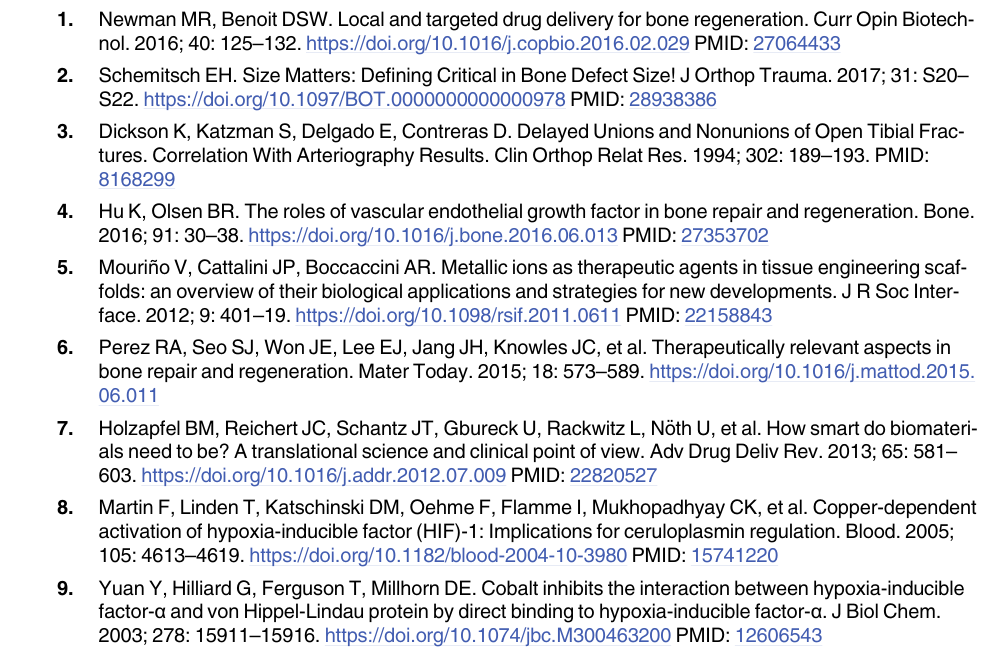
S2 Table. HIF-1 α and VEGF expression correlation results with Co 2+